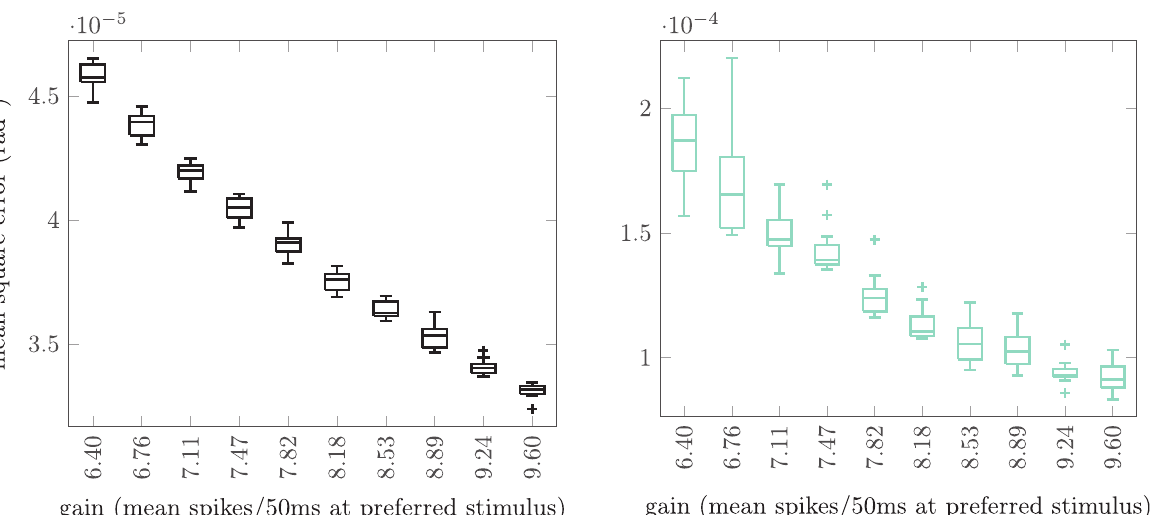
Fig 6. Network sensitivity to instantaneous reliability. The instantaneous (one-time-step) reliability of sensory information is determined by the total number of spikes across the sensory population within one time step. An optimal filter will up-weight sensory information that is more reliable (and vice versa). If such a filter is run on noiseless sensory data, then its errors will be smaller for sensory input with more total spikes (higher gain), since it will up-weight the perfect sensory information. (A) Box-and-whisker plot (interpretation as in Fig 4) of mean squared errors for the optimal model (OPT), when tested on noiseless sensory data and a range of gains. For each gain on the abscissa, the filter was tested on 12 sets of 320 trajectories apiece, for which the sensory gain was fixed throughout. Higher-gain trajectories yield lower mean errors, as expected. (B) The same plot for the network (rEFH). The magnitude of the MSEs is larger than for the optimal filter, as in Fig 1E, but the pattern is the same, showing that the rEFH has indeed learned to treat higher-gain (more- spikes) sensory information as more